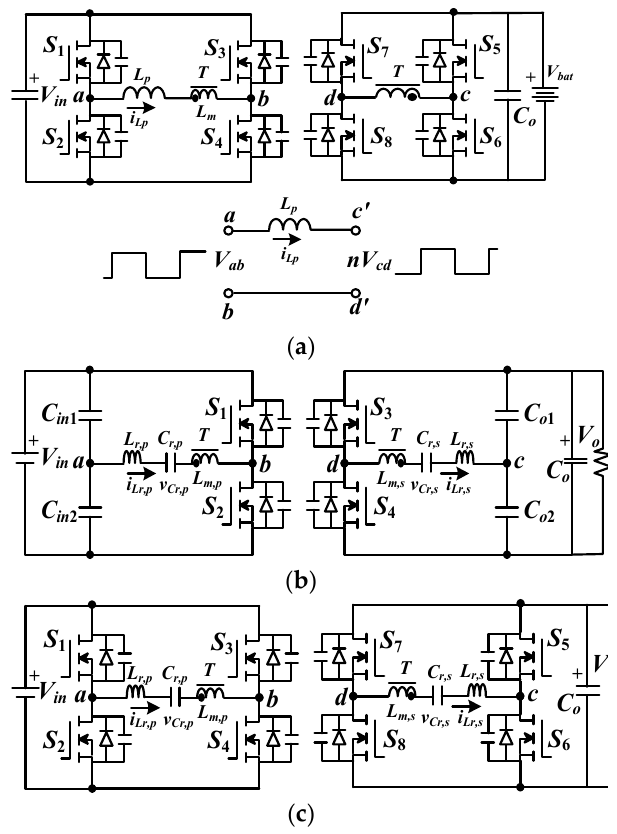
Figure 4. Bidirectional DC/DC converters: ( a ) dual active bridge structure with pulse-width modulation, ( b ) resonant circuit with half bridge structure, ( c ) resonant circuit with full bridge structure.